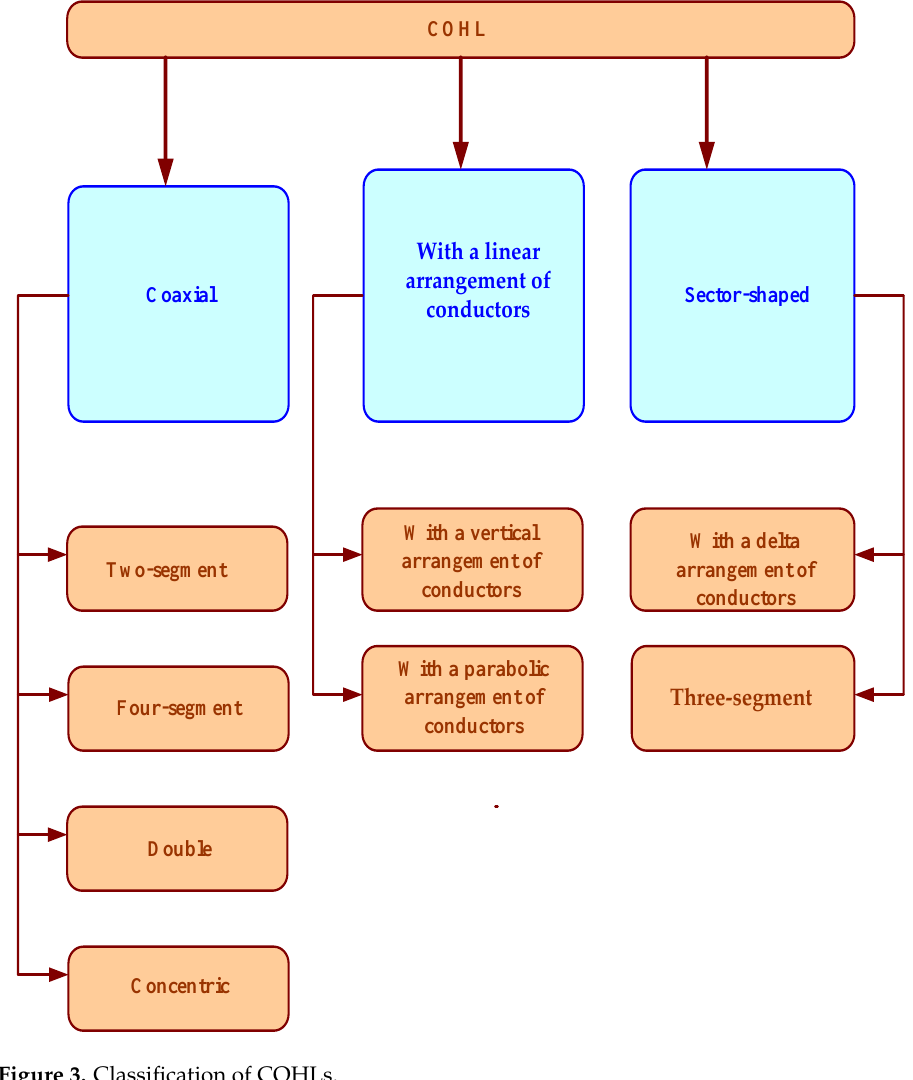
Figure 2. Coordinates of the arrangement of conductors of the power line of a standard design.